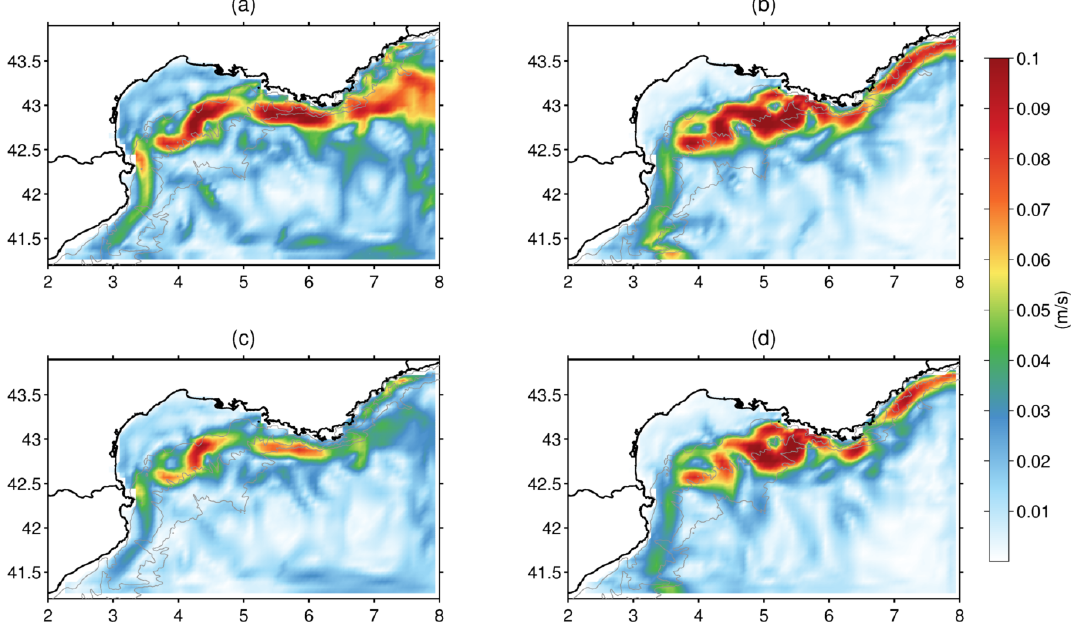
Figure 10. Vector speed difference computed over the assimilation period between free surface current and analyzed surface current from (a) WindReal or (b) ObcReal , and free current and analyzed current integrated over the first 200m below the surface from (c) WindReal or (d) ObcReal . The 100, 1000 and 2000m isobaths are drawn (gray lines).